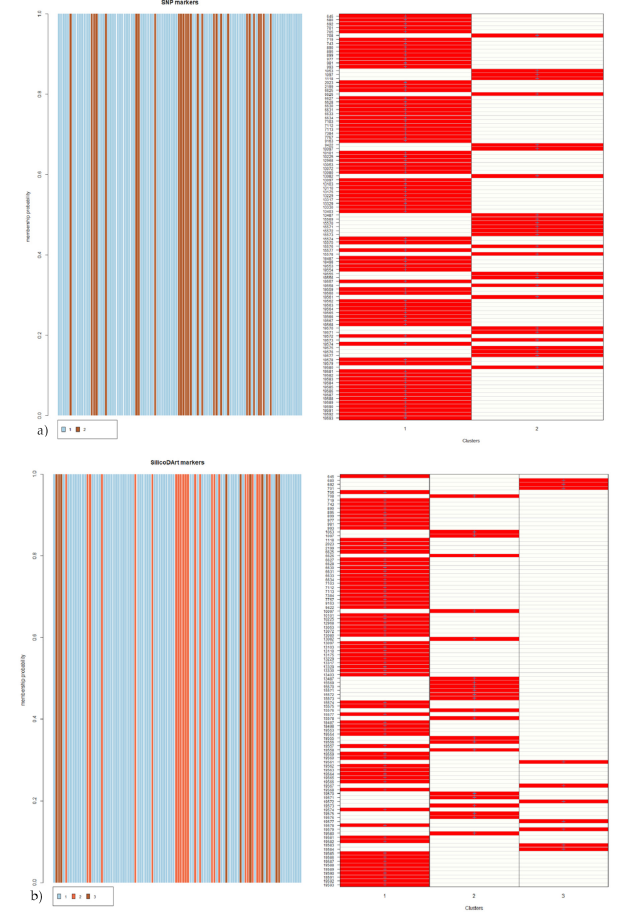
Figure 6. Accessions cluster membership probability and assignment of accessions to each cluster based on ( a ) SNP and ( b ) SilicoDArT